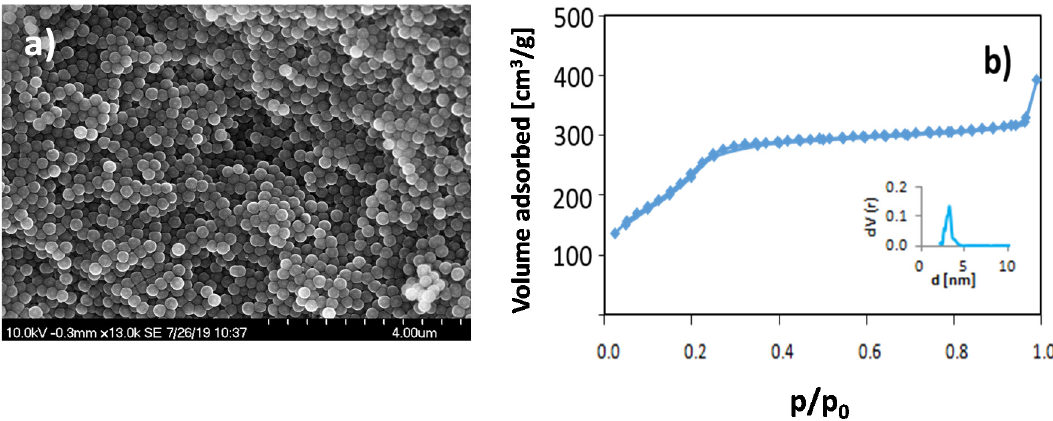
Figure 1. ( a ) SEM image of calcined mesoporous silica nanoparticles (MSNs) showing the narrow particle size distribution, and ( b ) the nitrogen sorption isotherm measured at 77 K for the same particles. The inset in Figure 1b shows the pore size distribution plot.